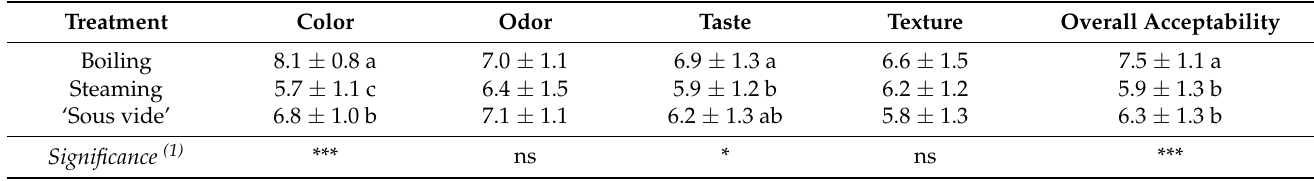
Table 2. Sensory analysis of golden thistle midribs cooked with different methods. Evaluation of samples resulted from scoring five macro-descriptors with the hedonic scale having a scale from 1 (highly unacceptable) to 9 (highly acceptable). Mean values ±